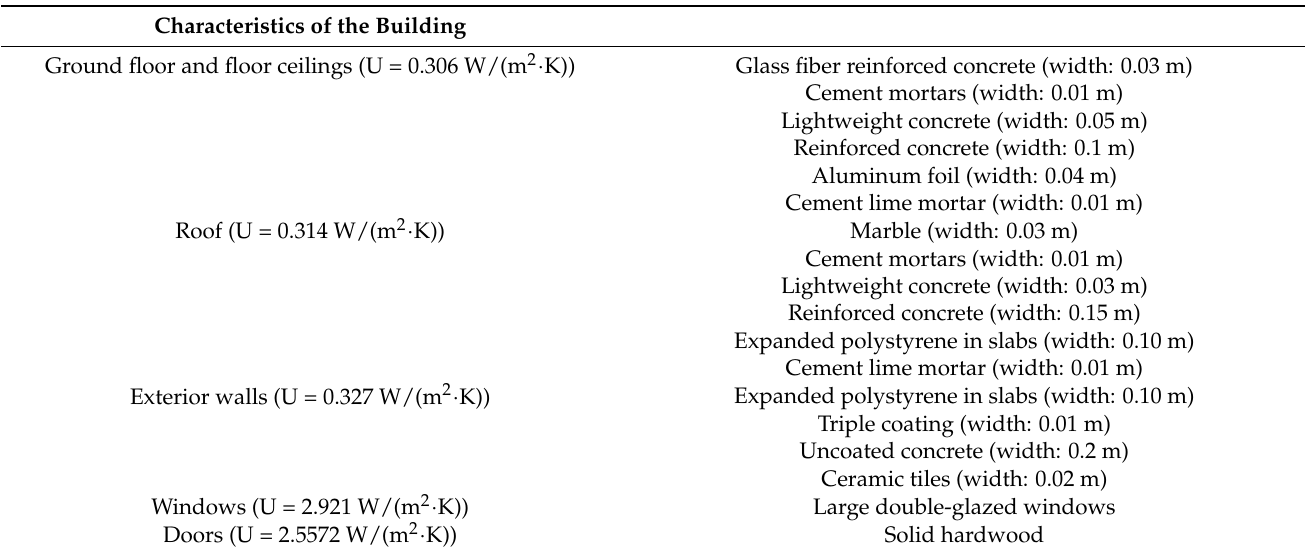
Table 2. Main characteristics of the University